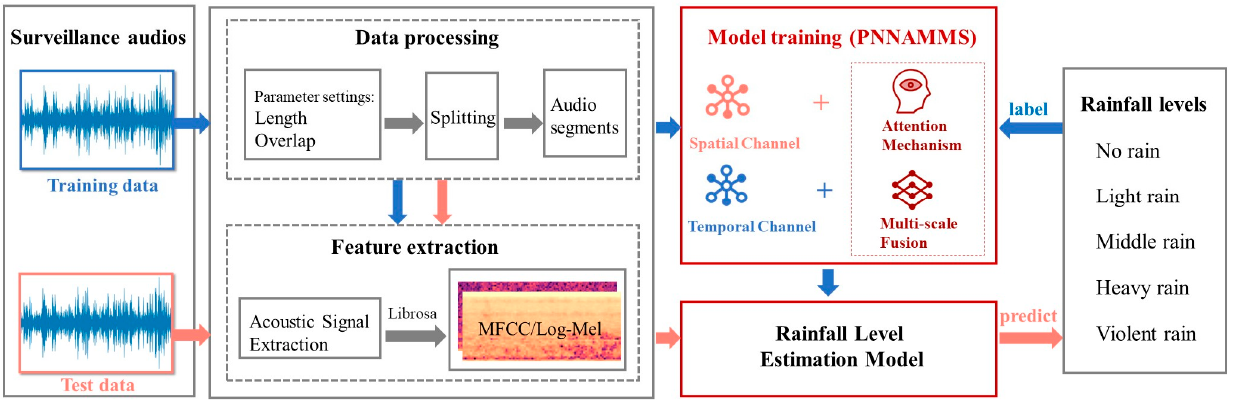
Figure 2. Surveillance audio-based rainfall estimation (SARE) architecture system based on the proposed parallel network based on attention mechanisms and multi-scale fusion (PNNAMMS).